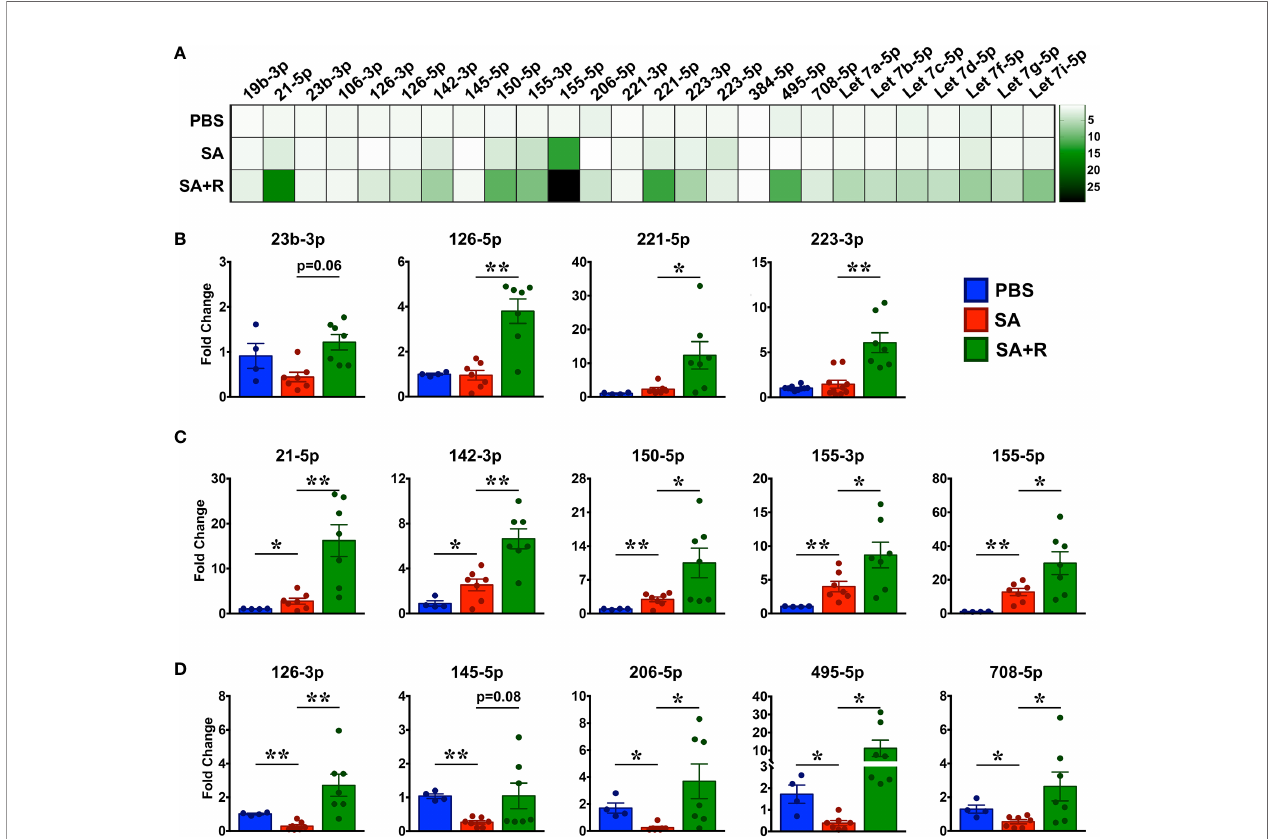
FIGURE 8 | Increased expression of various miRNAs in the lungs of SA mice treated with Ruxolitinib. Lungs tissues of PBS-injected, SA and SA+R mice were analyzed for gene expression of various miRNAs as indicated in the fi gure. (A) Heat map of gene expression of various miRNAs in the lungs of SA and SA+R mice, normalized to PBS controls. (B – D) Fold change in expression of various miRNAs in the lungs of SA and SA+R mice with known roles in asthma pathogenesis. Fold change for each cohort was normalized to PBS-treated mice. Data is presented as mean ± SEM and are pooled from 2 independent experiments with a total of n=4 mice for PBS controls and n=7 mice for SA and SA+R groups. Statistical signi fi cance was determined using Student ’ s unpaired t test with Welch ’ s correction. *p ≤ 0.05 or **p ≤